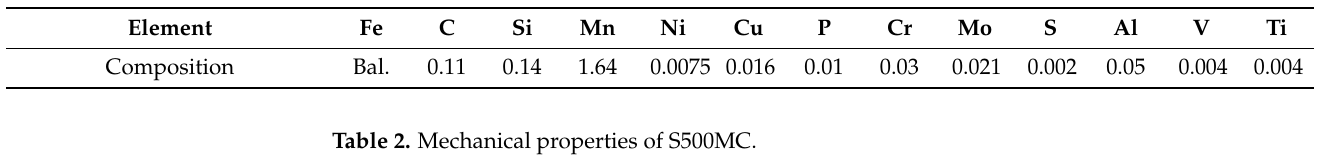
Table 1. Chemical composition of S500MC (wt.%).